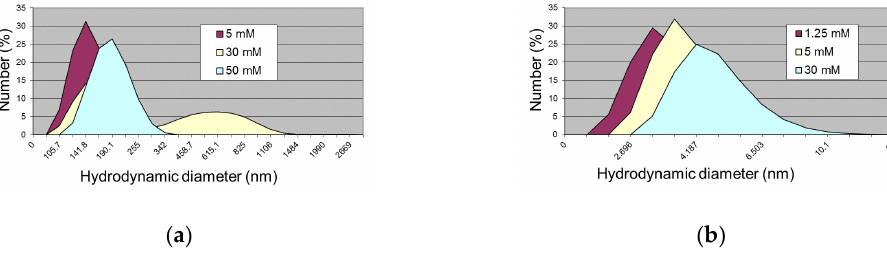
Figure 9. Particle size distribution of GCR-1 ( a ) and GCR-2 ( b ) in 50% DMSO–50% water, 25 °C.